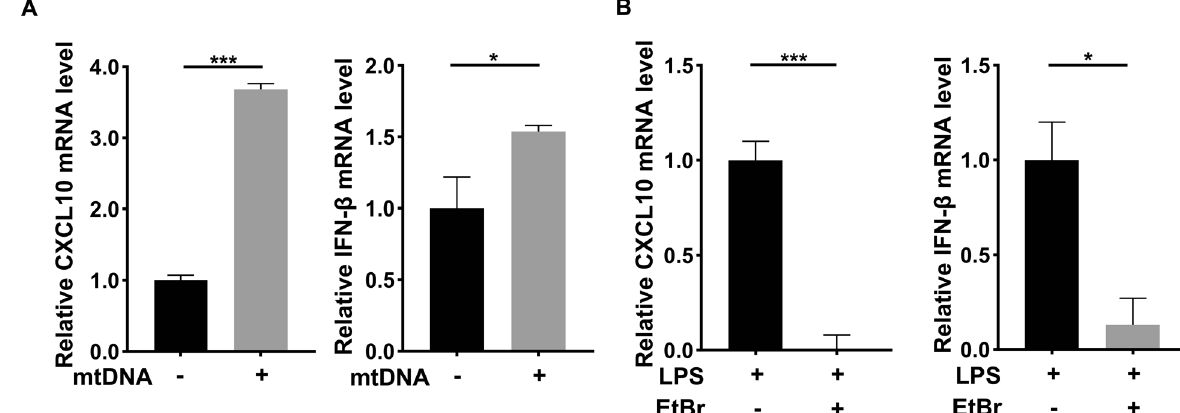
Fig. 4 Cytosolic mtDNA exacerbated in fl ammatory progression. A The mRNA level of in fl ammatory cytokines, CXCL10 and IFN- β was detected by qPCR after overexpressing mtDNA (1 μ g/well). B qPCR was performed to assess the CXCL10 and IFN- β mRNA level in